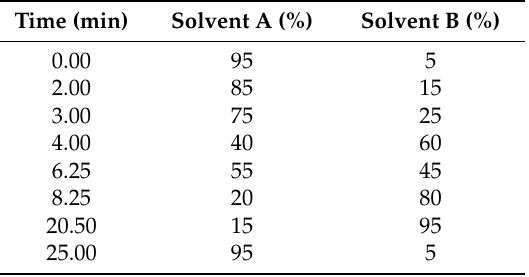
Table 1. Solvent gradient program for UPLC analysis.